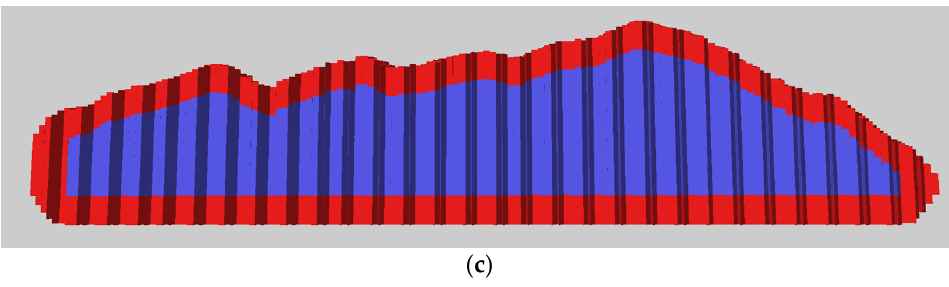
Figure 9. Cross-sectional views of the target area and its buffers with 40 ( a ), 120 ( b ), and 200 m ( c ) radii at the sphere grid level of 18. Cells marked as the target area are shown in blue, and cells marked as the buffer are shown in red.